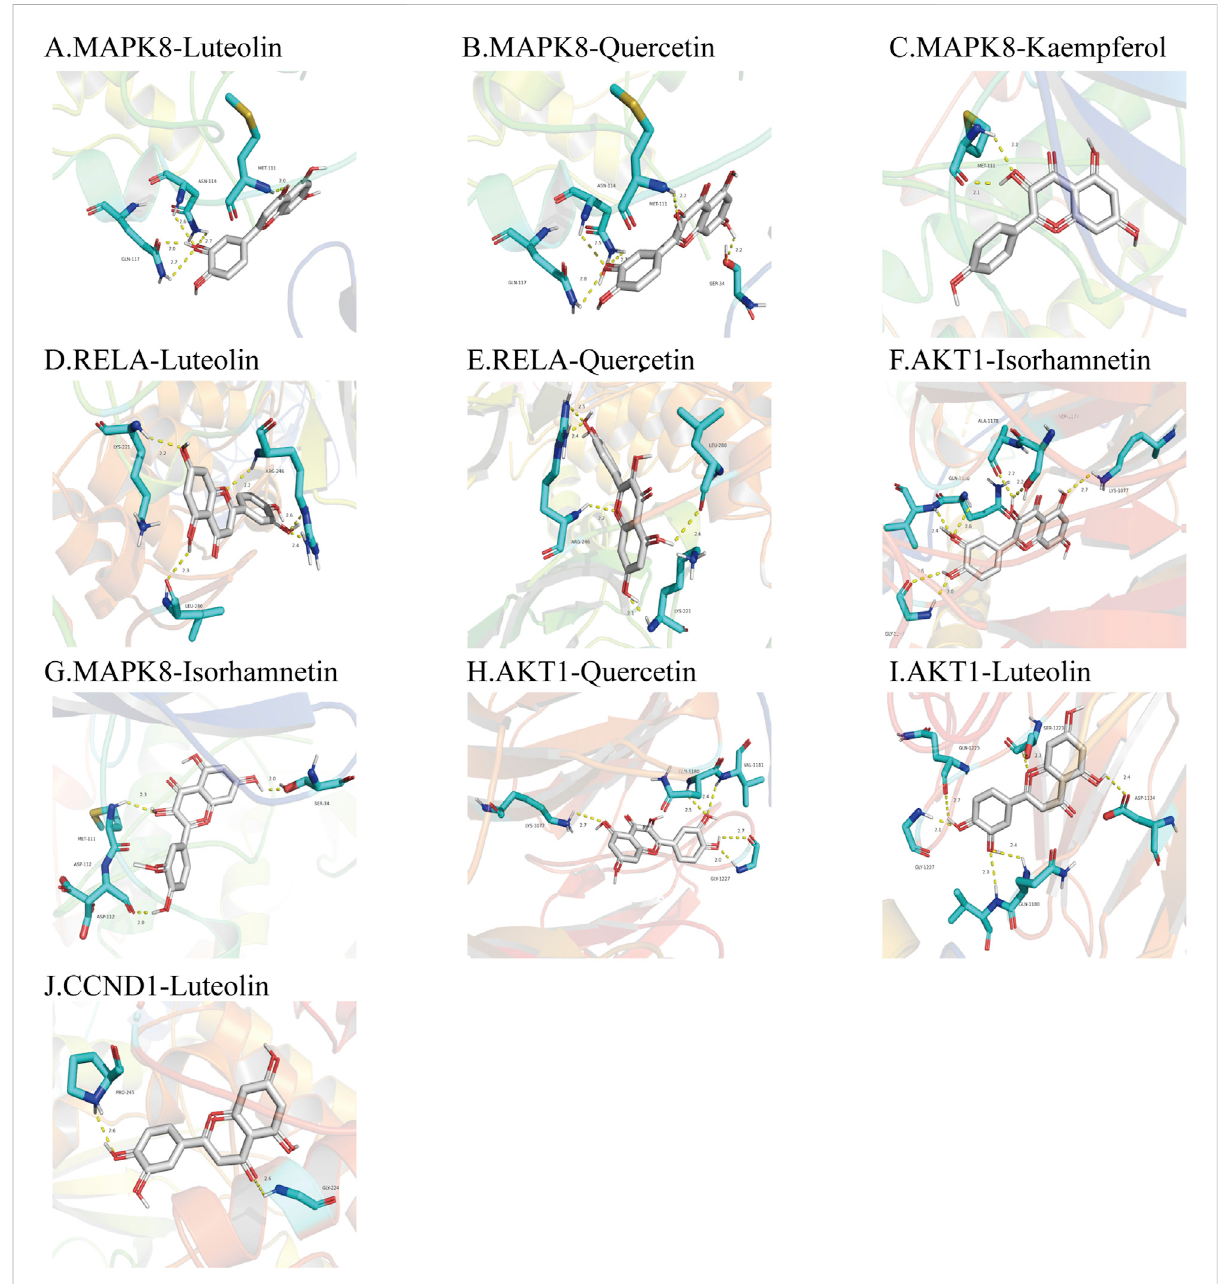
FIGURE 8 Molecular docking diagrams of the top 10 molecular docking maps with low binding energies. The protein active site, binding distance, and molecular docking model between the protein and the main active ingredient were shown in Figure 8. (A) . MAPK8-Luteolin ( − 9.9 kcal/mol); (B) . MAPK8-Quercetin ( − 9.7 kcal/mol); (C) . MAPK8-Kaempferol ( − 9.2 kcal/mol); (D) . RELA-Luteolin ( − 9.2 kcal/mol); (E) . RELA-Quercetin ( − 9.2 kcal/ mol); (F) .AKT1-Isorhamnetin( − 9.1 kcal/mol); (G) .MAPK8-Isorhamnetin( − 9.1 kcal/mol); (H) .AKT1-Quercetin( − 8.9 kcal/mol); (I) .AKT1-Luteolin ( − 8.7 kcal/mol); (J) . CCND1-Luteolin ( − 8.7